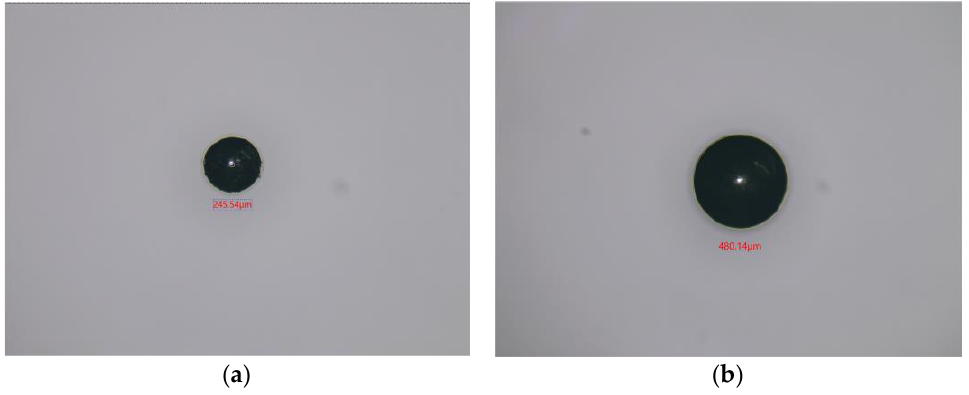
Figure 8. ( a ) Schematic diagram of the whole inspection system; ( b ) the experimental test platform.